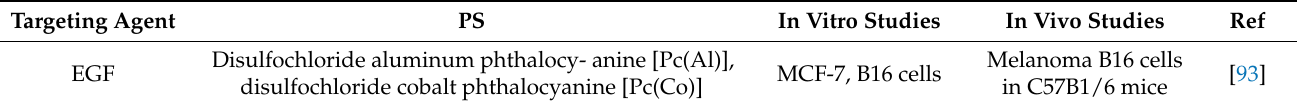
Table 1. EGFR-targeted PDT performed with EGF as the targeting agent.